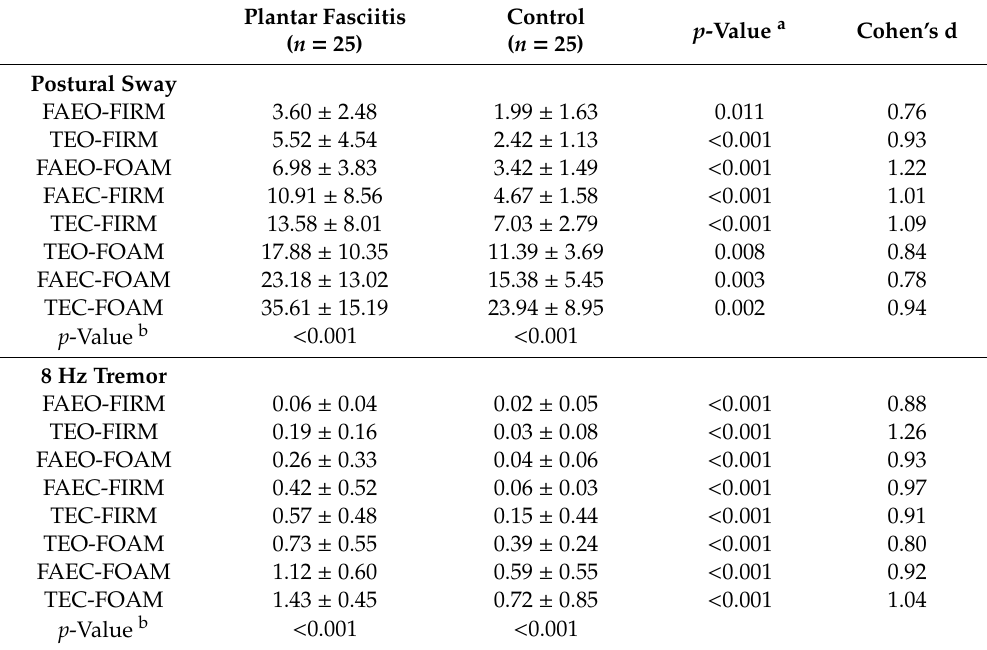
Figure 2. The tremor in the eight balance task challenges used here by increasing order of di ffi culty. Table 2. Postural sway and tremor during eight balance tasks in PF group and control